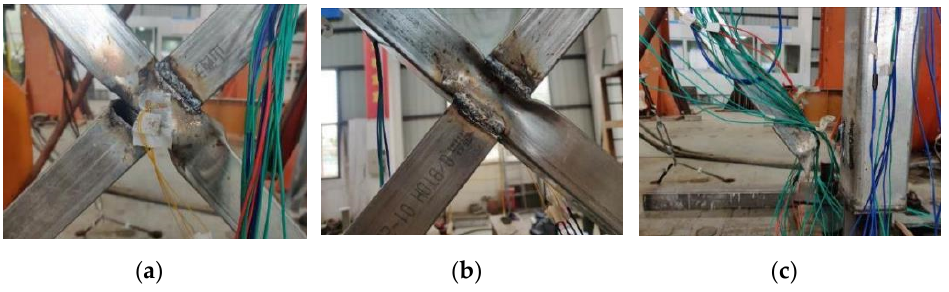
Figure 6. Test phenomena of FW-1 specimen: ( a ) Welding failure at the intersection of the lower bracings; ( b ) Buckling of the upper brace; ( c ) Welding failure at the end of the lower brace.